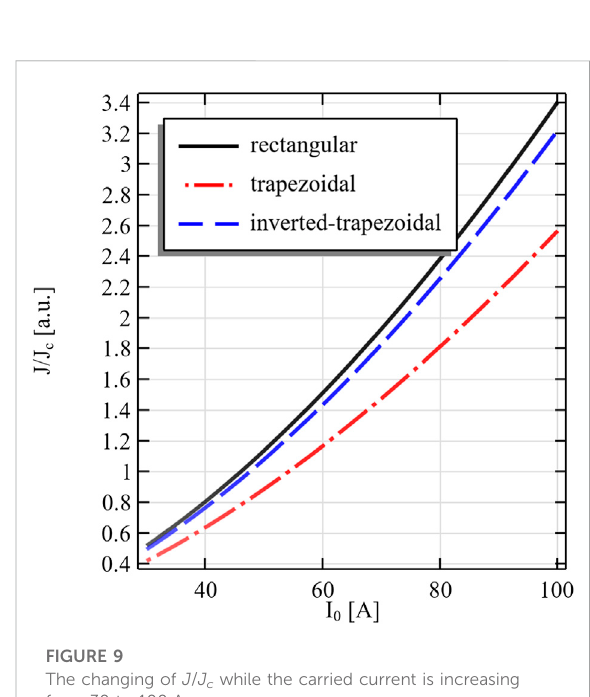
FIGURE 9 The changing of J / J c while the carried current is increasing from 30 to 100